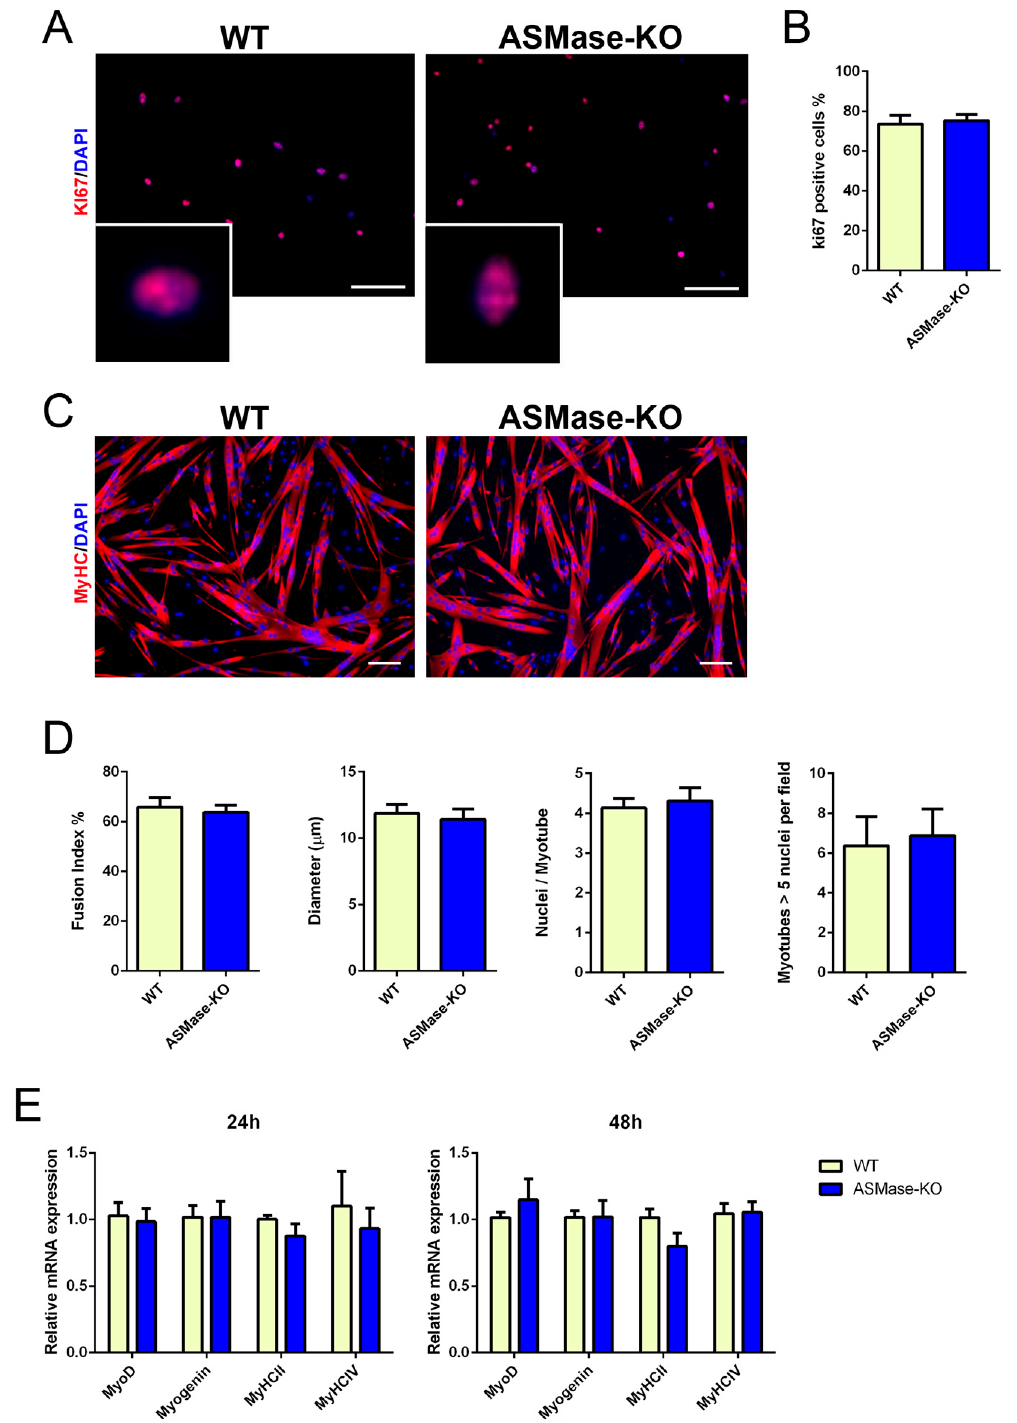
Figure 2. ASMase in satellite cells proliferation and differentiation in vitro. ( A ) Representative Ki67 immunostaining (red) and DAPI nuclear counterstaining (blue) of satellite cells isolated from WT and ASMase-KO mice and cultured for 24 h. Scale bar, 100 μ m. ( B ) Percentage of Ki67 positive satellite cells on total DAPI staining. Values are expressed as mean ± SEM ( n = 5 mice). ( C ) Representative MyHC immunostaining (red) and DAPI nuclear counterstaining (blue) of satellite cells isolated from WT and ASMase-KO mice and cultured for 48 h. Scale bar, 100 μ m. ( D ) Fusion index, mean myotubes diameter, mean number of myonuclei/myotube and percentage of myotubes with 5 or more nuclei of satellite cells from WT and ASMase-KO mice ( n = 9 mice). ( E ) RT-qPCR analysis of myogenic markers Myod, Myog, and MyHCII and MyHCIV ( n ≥ 4